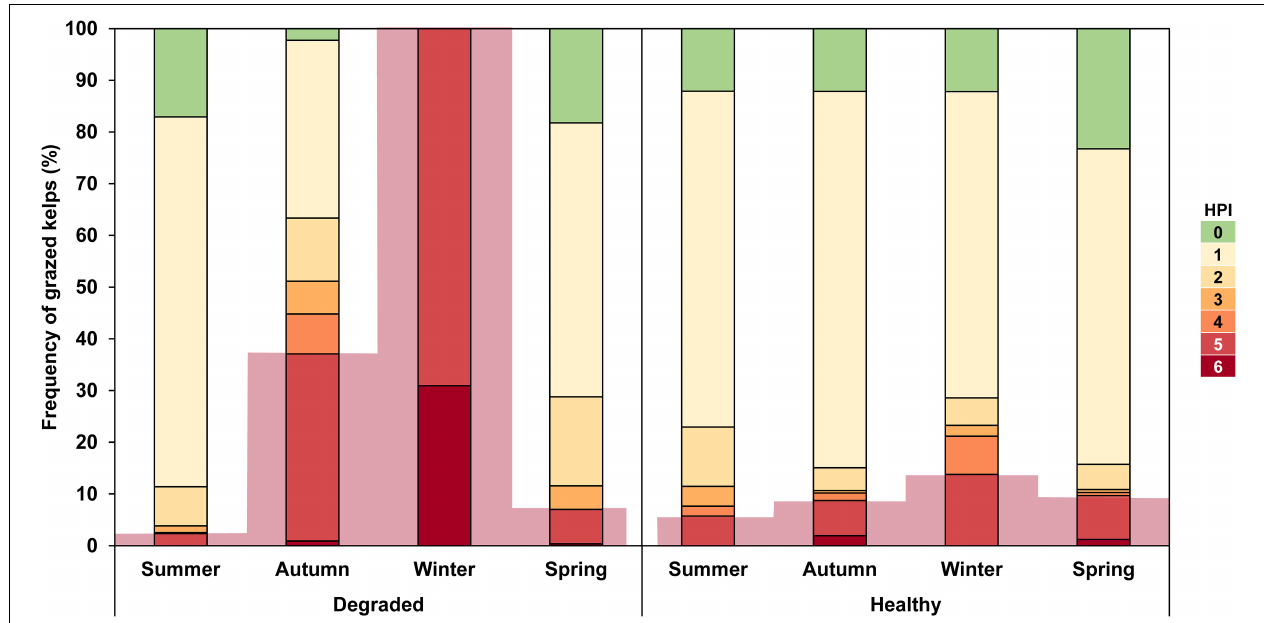
FIGURE 5 | Laminaria ochroleuca . Seasonal changes in the frequency of Herbivory Pressure Index (HPI) categories in kelps sampled on degraded ( n = 1,090) and healthy ( n = 883) golden kelp reefs. HPI-0 = no bite marks, HPI-1 ≤ 25% of the blade edge with bite marks, HPI-2 = 25–50% of the blade edge with bite marks, HPI-3 = 50–75% of the blade edge with bite marks, HPI-4 = 75–100% of blade edge with bite marks, HPI-5 = stipe and holdfast only, HPI-6 = holdfast only. Light-red background shading highlights changes in the frequency of ecologically dead kelps (i.e., downgraded to a meristem-less stage by herbivory).